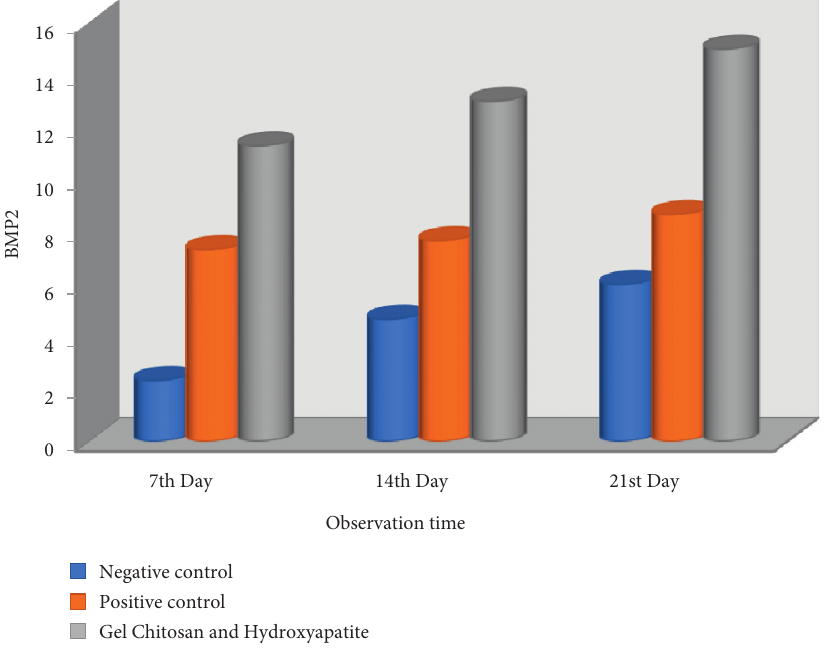
Figure 6: Bar chart of BMP-2 expression between treatment